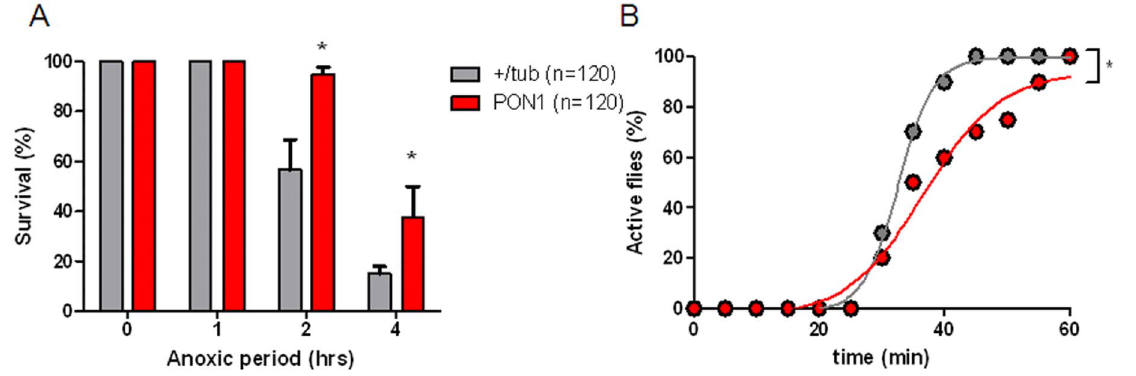
Figure 2. Survival and recovery from stupor after anoxia-reoxygenation. + /tub and PON1 flies were exposed to anoxia for different time periods 1–4 hours. A) survival registered 24 hours after reoxygenation. B) percentage of flies that recover from stupor over time. *p , 0.05 when compared with + /tub.